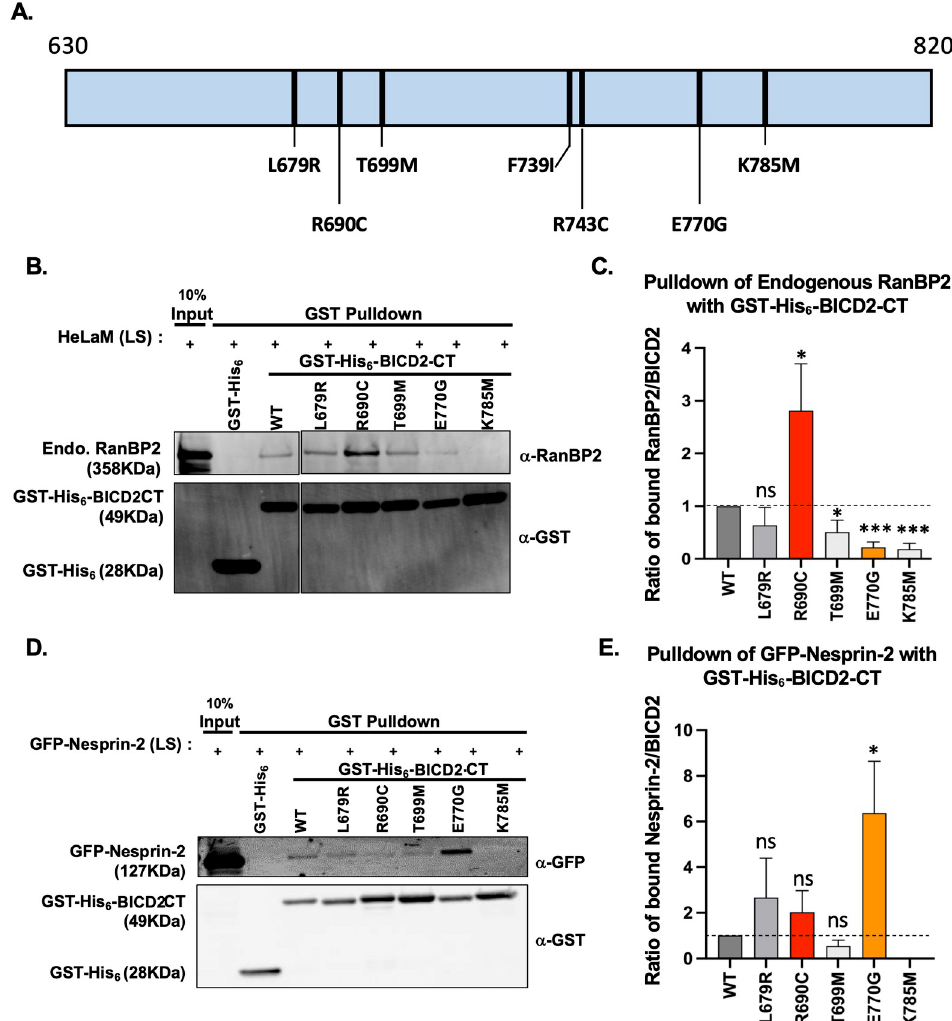
Fig 3. Human BICD2 mutations with defects in RanBP2 and/or Nesprin-2 interactions. (A) Depiction of BICD2-CT (aa 630–820, note BICD2 CC3 fragment is aa 711–800) with each missense mutation marked ( black bars) . Human disease causing mutations of BICD2 (L679R, R690C, T699M, and E770G in mouse Bicd2 ), one Drosophila mutation (K785M in mouse Bicd2 ) and the registry-shift locking mutations (F739I and R743C) are marked to show their relative positions within the BICD2 CT region. (B-E) GST-His 6 -BICD2 CT WT and missense mutant forms of this construct were used in pull-downs from HeLaM cell lysates. The co-precipitated proteins were identified by immunoblotting against anti-RanBP2 or anti-GFP to detect GFP-Nesprin-2 and GST for the BICD2 CT proteins. (B) Immunoblot of GST pulldown from untransfected HeLaM cell lysate using anti-RanBP2 and anti-GST antibodies. (C) Ratio of the RanBP2 signal intensity to the GST signal is normalized to the wildtype control. (D) Western blot of GST pulldown from GFP-Nesprin-2 expressing HeLaM cell lysate, immunoblotted with anti-GFP and anti-GST antibodies. (E) Ratio of the GFP signal intensity to the GST signal is normalized to the wildtype control. We note that GFP-Nesprin-2 was not detectable in the pulldown for K785M mutation. n = 4 for (B,C) and n = 3 for (D,E); All error bars are S.E.M. Student’s t-test was performed against the wildtype control. ( � p < 0.05; �� p < 0.01; ��� p < 0.001; ns = not significant). increased Nesprin-2 binding (Fig 3D and 3E), showed markedly reduced binding to RanBP2 (Fig 3B and 3C), consistent with the mutually exclusive interaction characteristics we observed for Nesprin-2 and RanBP2 with the BICD2 CC3 domain, as described above.